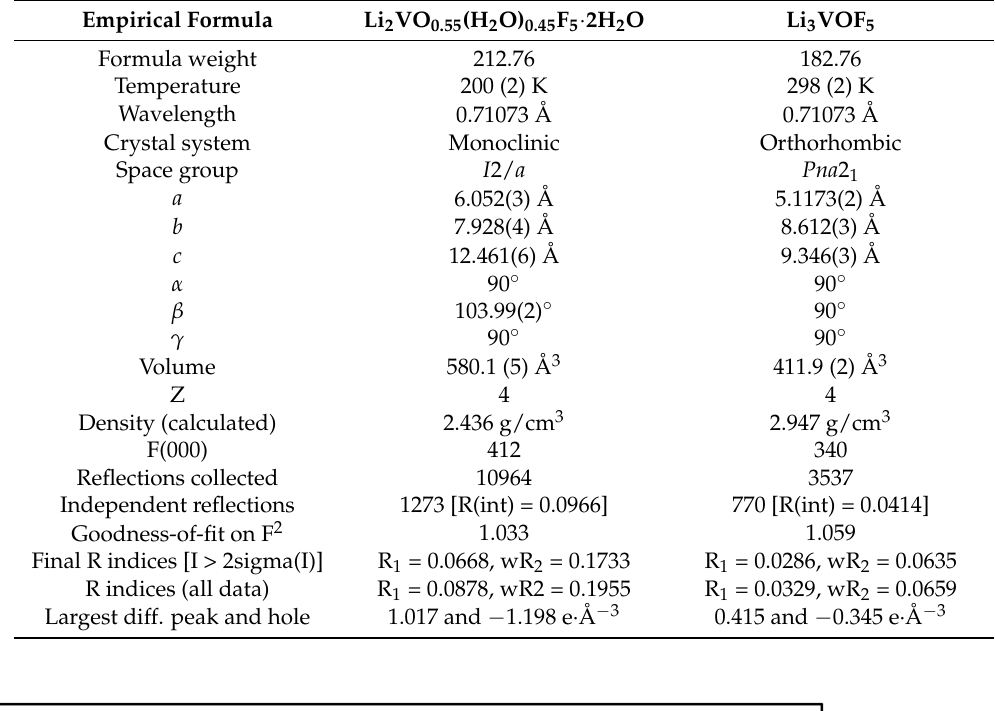
Table 1. Crystal data and structure refinement for Li 2 VO 0.55 (H 2 O) 0.45 F 5 · 2H 2 O ( I ) and Li 3 VOF 5 ( II ).